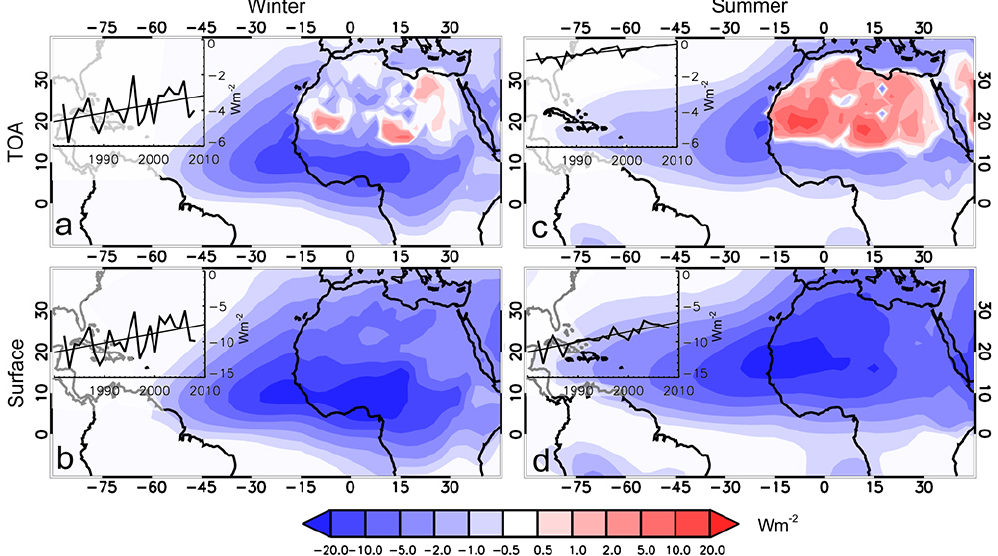
Figure 1. Spatial maps of the average direct radiative effect of dust (DRE) at the surface and TOA are shown for both winter (left) and summer (right) seasons. The average is based on model output over the period 1982–2008. The inset shows the seasonal average DRE over the region 0–30 ◦ N, 50 ◦ W–15 ◦ E. The thin black line indicates the trend over the simulation period.